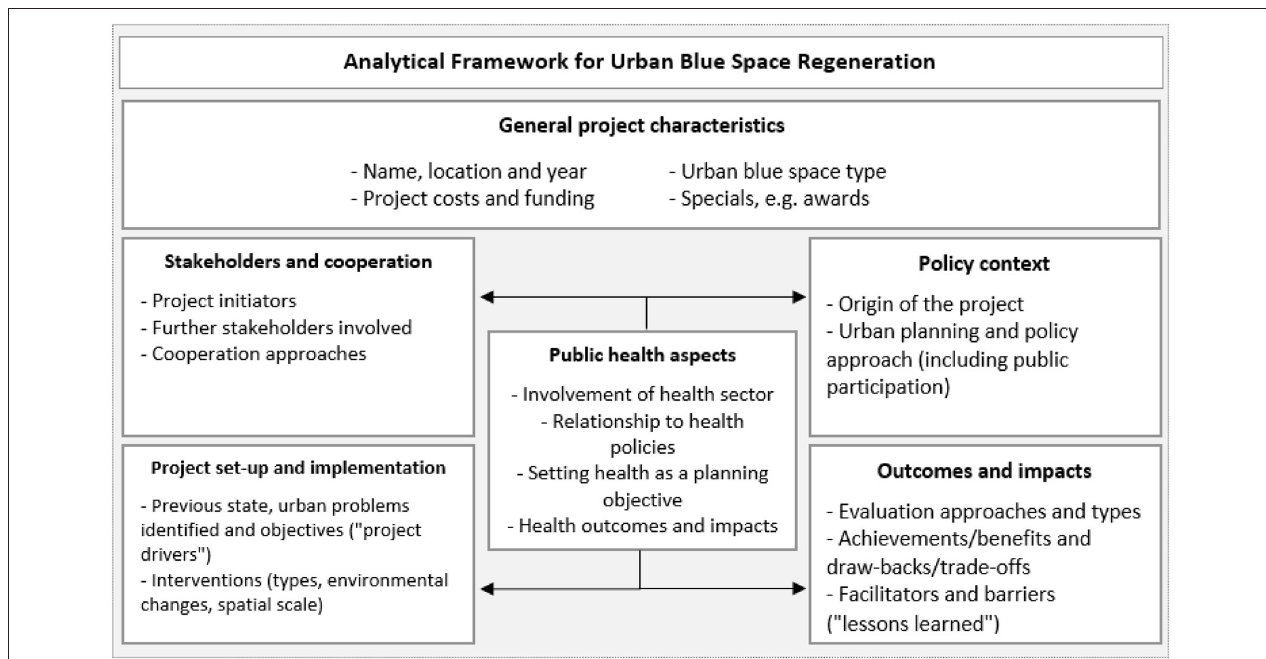
FIGURE 2 | Framework for analyzing urban blue regeneration schemes [modified from (14)].